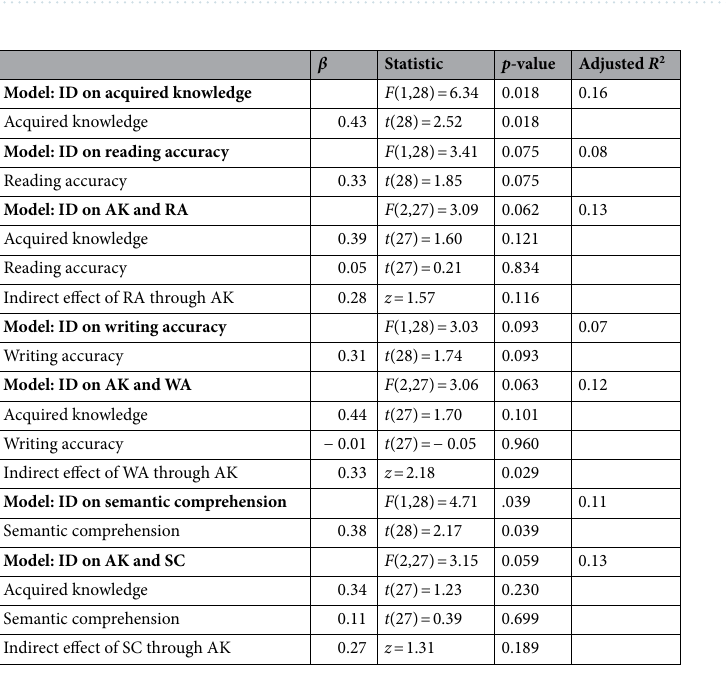
Table 5. Testing for indirect effects of kanji abilities on idea density via acquired knowledge. Note: n = 30. β standardized regression coefficient, p-value significance in t or F test, Adjusted R 2 variance explained